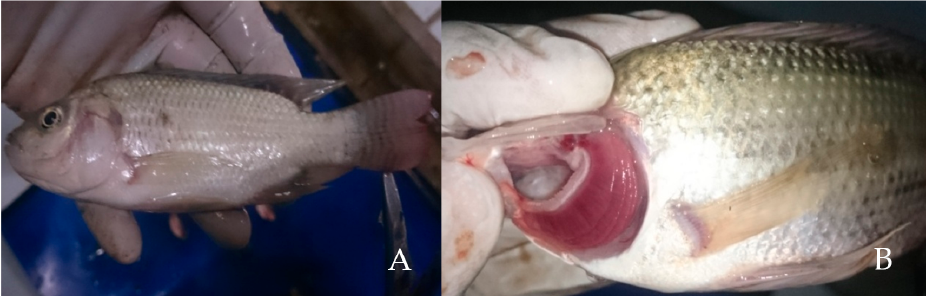
Figure 2. Pathological conditions of freshwater fish ( Oreochromis niloticus ) after exposure to Hg(II). ( A ) whitish body and eyes and ( B ) pale gills color. ( A ) whitish body and eyes and ( B ) pale gills